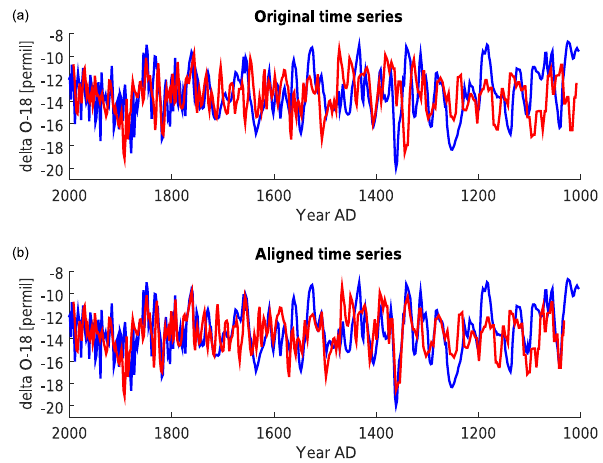
Figure 5. Stable water isotope time series of KCC and KCI, shown in blue and red, respectively: (a) shows both records on their orig- inal timescale over the last 1000 years; (b) the KCI age scale was adjusted using the algorithm of Lisiecki and Lisiecki (2002) to op- timize the match with